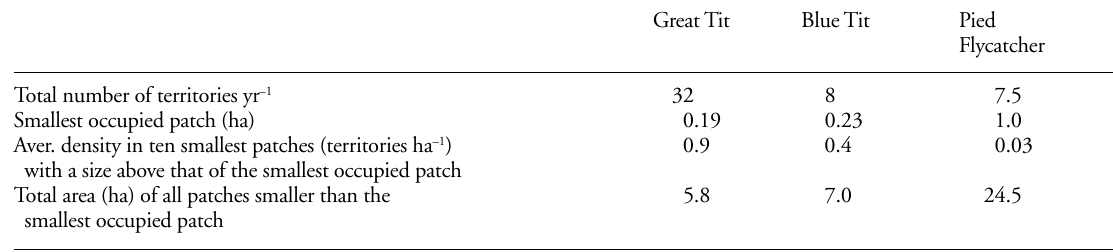
Table 1. Territories recorded in a set of 135 patches (0.01–24 ha large) where territories where mapped in 1982 and 1983. There were no nest boxes in these patches. Comparing the two bottom rows gives an estimate of the number of territories expected in small patches if these were not avoided (see discussion).